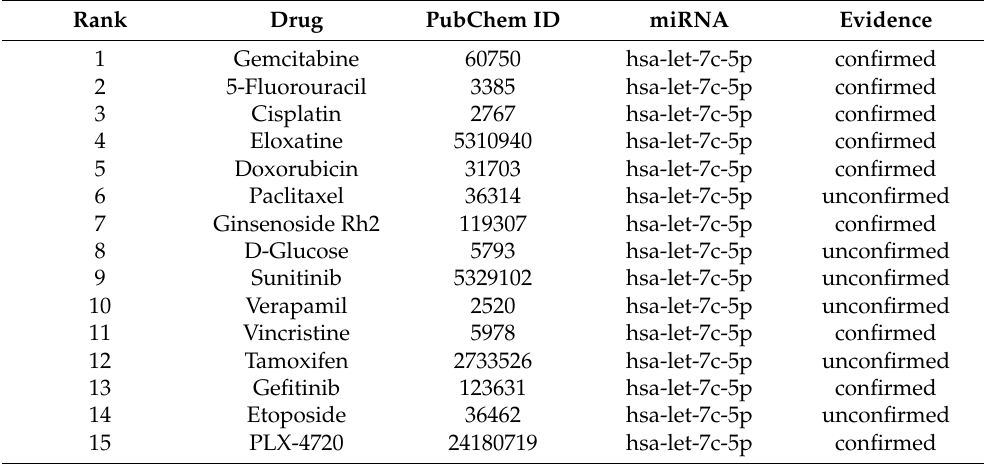
Table 7. The top 15 predicted drugs interacting with the miRNA hsa-let-7c-5p.